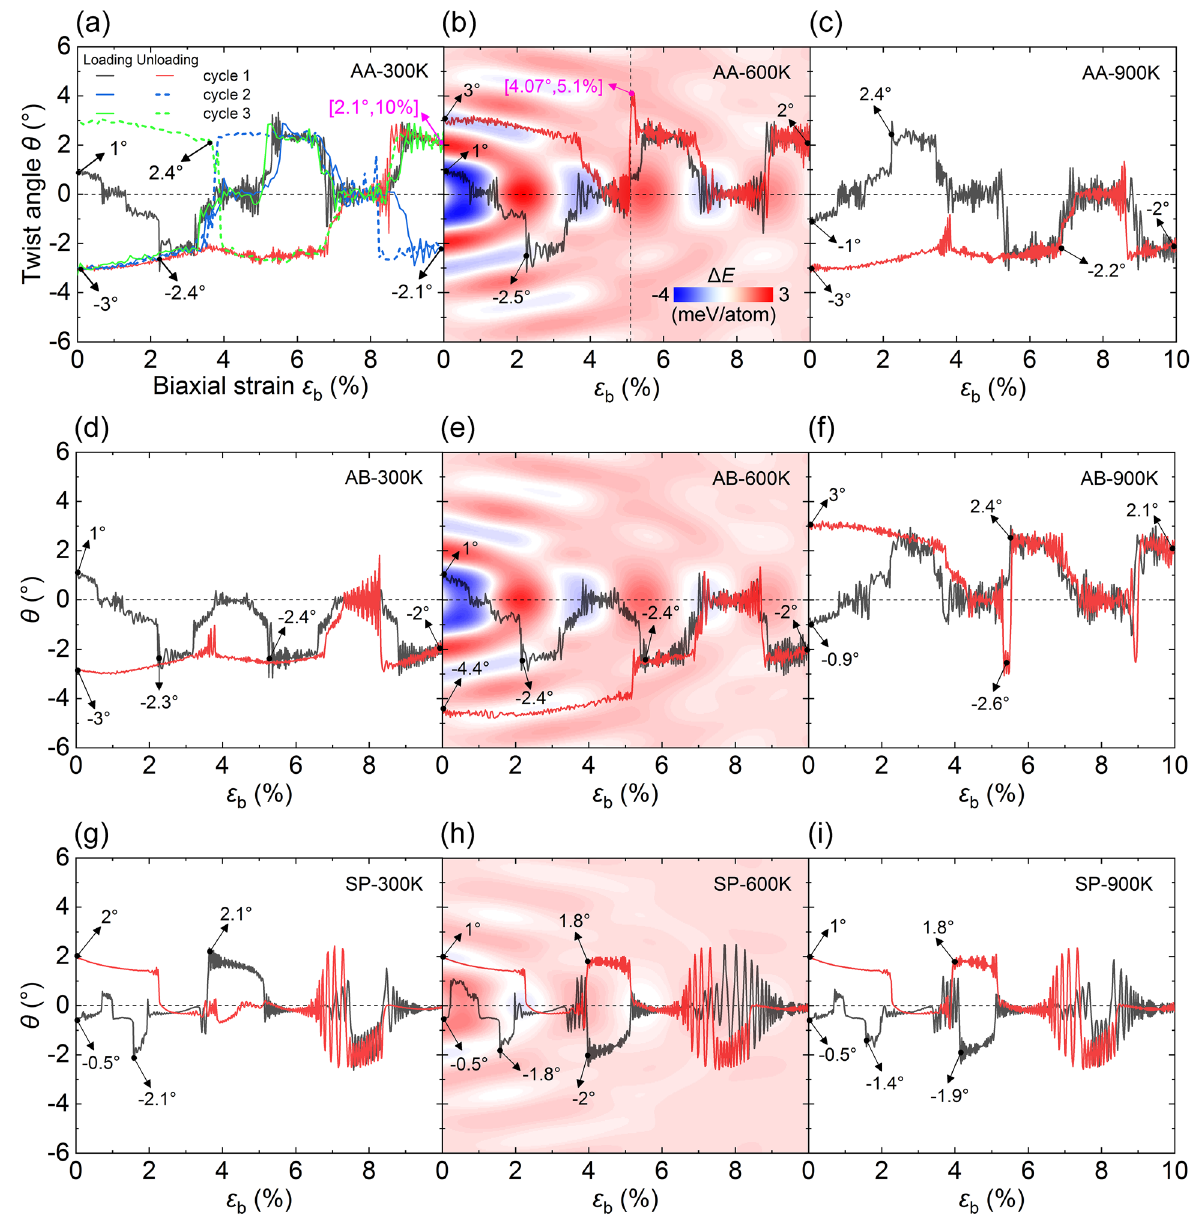
Figure 3. Heterostrain (strain rate = 0.025/ns) and temperature-modulated dynamic twisting of the graphene flake. ( a – c ) for the AA mode, ( d – f ) the AB mode, and ( g – i ) the SP mode. The first, second, and third cycle strain loading are presented in (a), and only the first cycle is plotted in ( b – i ). Interlayer energy landscapes are superimposed in ( b ), ( e ), and ( h ) to illustrate the interlayer energy-dominated twisting path. Each data is calculated using the energy value of θ = 0° as the benchmark. The legend in ( b ) also applies to ( e ) and ( h